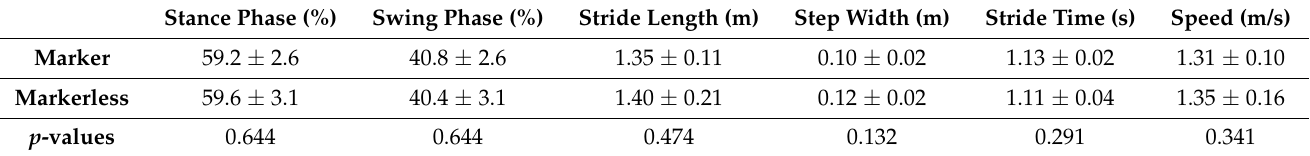
Table 2. Spatio-temporal parameters computed with marker-based and markerless systems, and sta- tistical results of the comparison between the two methods (last row). We report the mean ± the standard deviation of each parameter. The stance and swing phases are reported in % with respect to the whole gait cycle; stride length and step width and expressed in meters (m); stride time in seconds (s); and the speed in meters per second